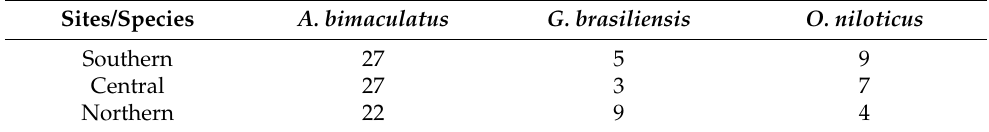
Table 2. Number of fish species sampled at each site of M ã e-B á Lagoon.